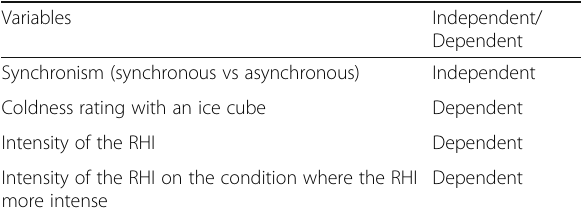
Table 2 All of the variables in the coldness condition Variables Independent/ Dependent Synchronism (synchronous vs asynchronous) Independent Coldness rating with an ice cube Dependent Intensity of the RHI Dependent Intensity of the RHI on the condition where the RHI more intense